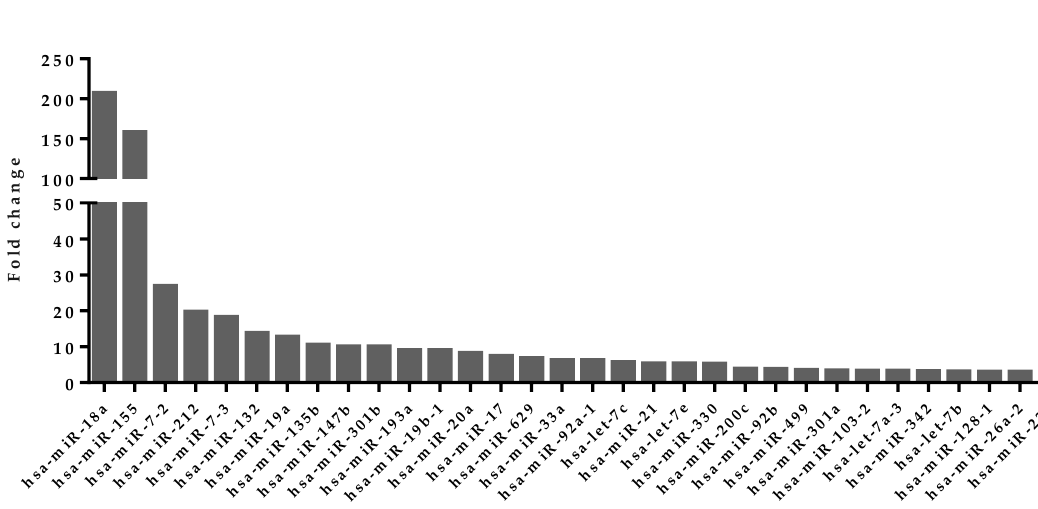
Figure 1. List of 32 miRNAs potentially induced by NFAT transcription factor with the fold change of expression in activated T cells. These miRNAs were observed to be highly overexpressed in activated T cells compared to non-activated T cells.